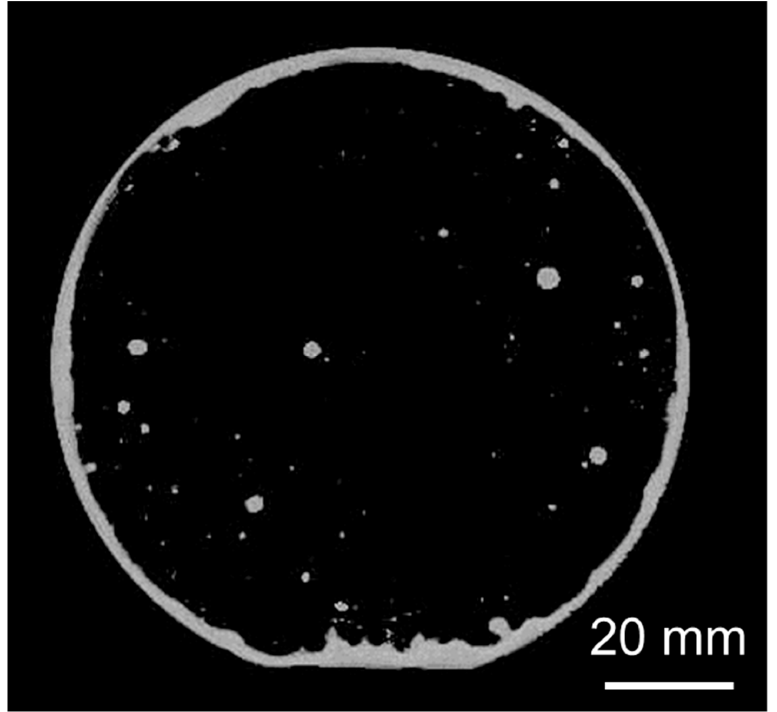
Figure 9. SAM image of Si wafers bonded using the transferred Au/Ti/Au getter layer and the Au/Ti bonding layer.